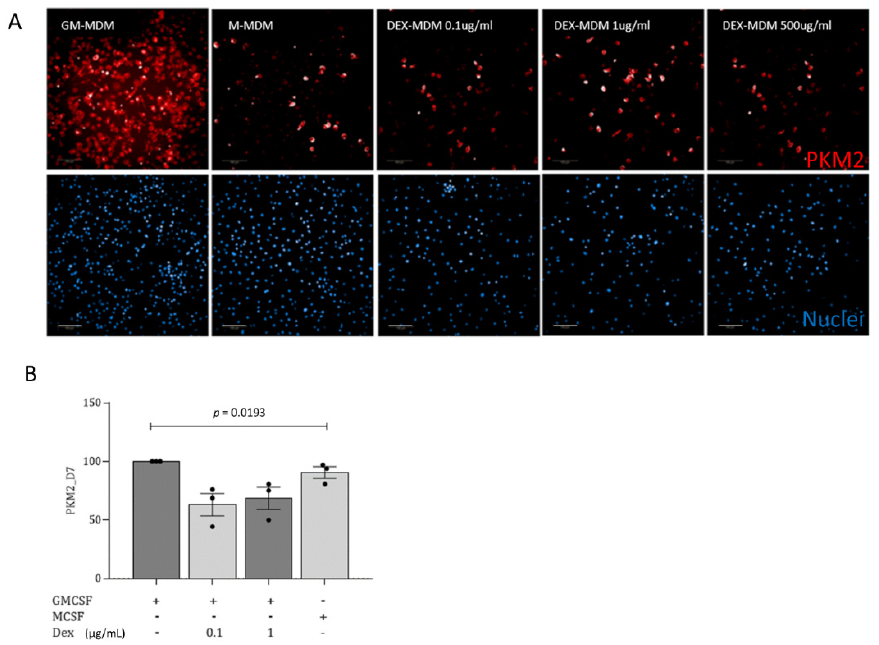
Figure 4 . Dexamethasone decreases PKM2 activity in GM-MDMs. ( A ) PKM2 was visualized using HCS (Operetta CLS, Perkin Elmer) and the 20x water objective, NA 1.0. The images depict a downregulated PKM2 expression following treatment of GM-MDMs with 100 ng/mL, 1 µg/mL, and 0.5 mg/mL Dex. Scale bar, 100 µm. ( B ) Flow cytometric analyses in three independent donor cells also revealed that the presence of Dex during the monocyte-to-macrophage differentiation process significantly decreases PKM2 levels. M2-MDMs served as controls. Experiments were repeated independently three times, and statistical significance was evaluated using one-way ANOVA.